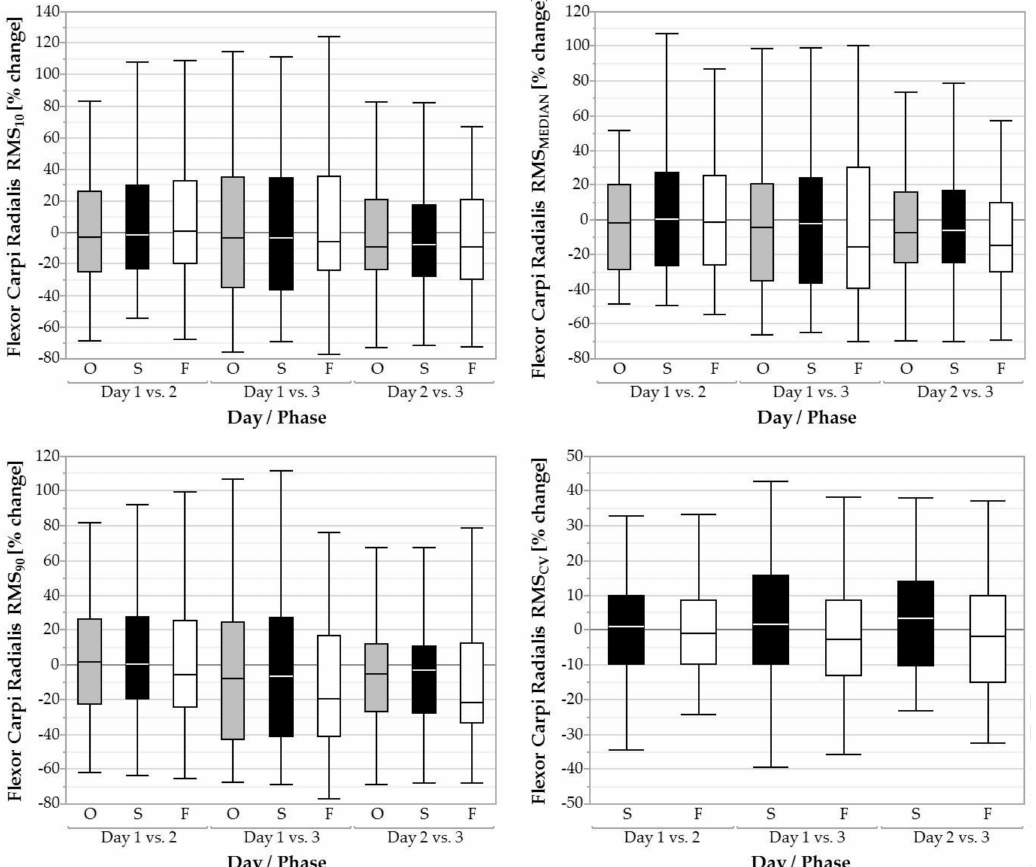
Figure 4. Boxplots of the 10th, 50th, and 90th percentile muscular activity (RMS 10 , RMS MEDIAN, RMS 90) and coefficient of variation (RMS CV ) of the flexor carpi radialis over three days for the overall task (O, grey filled boxplots), the screwing phases (S, black filled boxplots), and the fastening phases (F, white filled